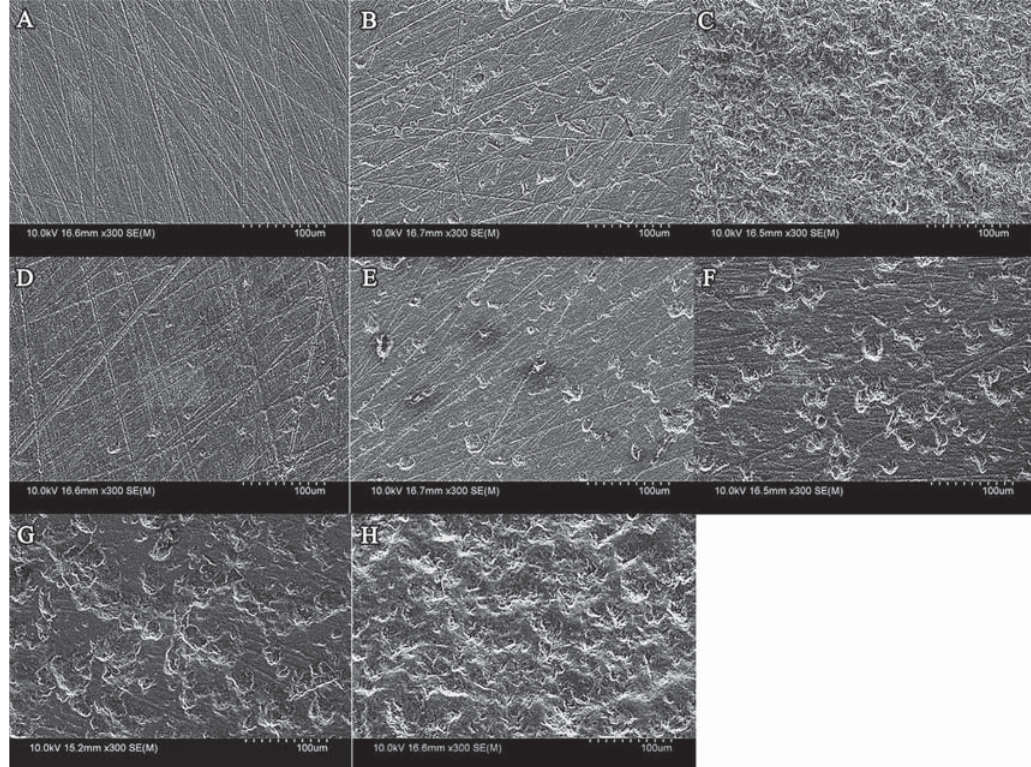
Figure 2- Scanning electron micrographs of the surfaces of the Cerasmart (CS) specimens after different pretreatments;